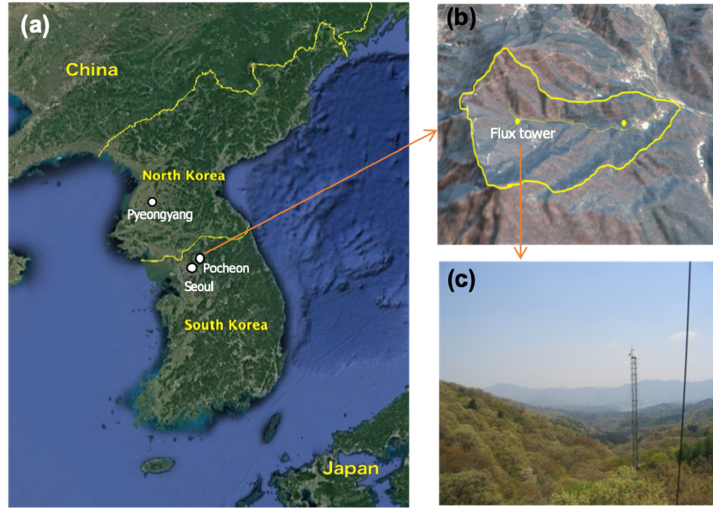
Figure 1. Gwangneung KoFlux supersite: the location in South Korea ( a ), a zoomed-in map with its watershed ( b ), and a photo of the flux tower ( c ).